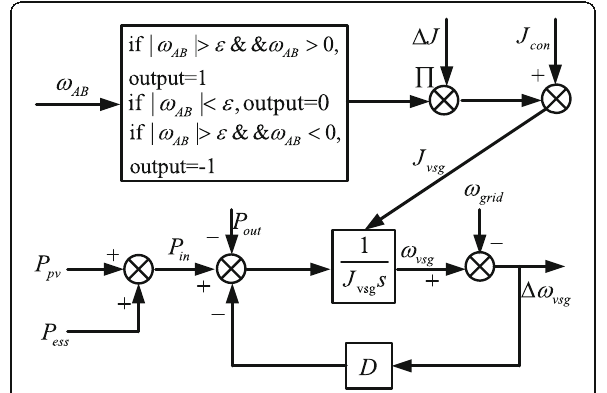
Fig. 6 Bang-bang control strategy of variable inertia